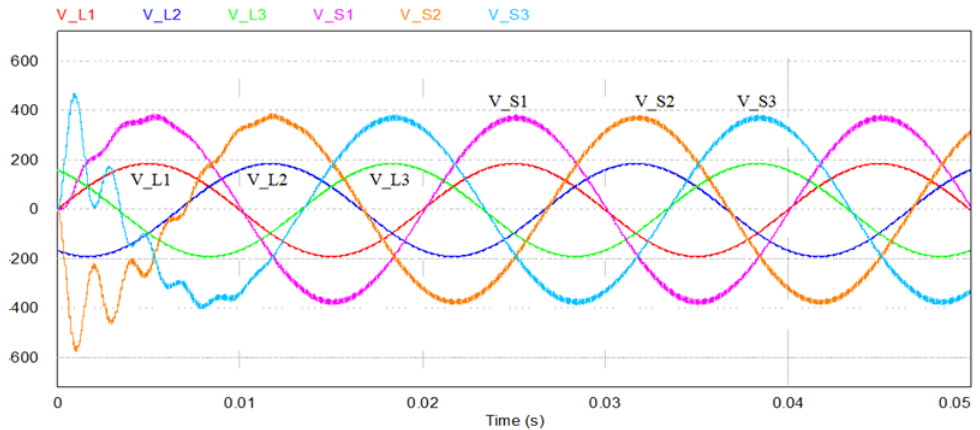
Figure 15. Waveforms of supply voltages and amplified voltages of the system output for Venturini modulation for q = 0.5 and R L = 30 Ω .